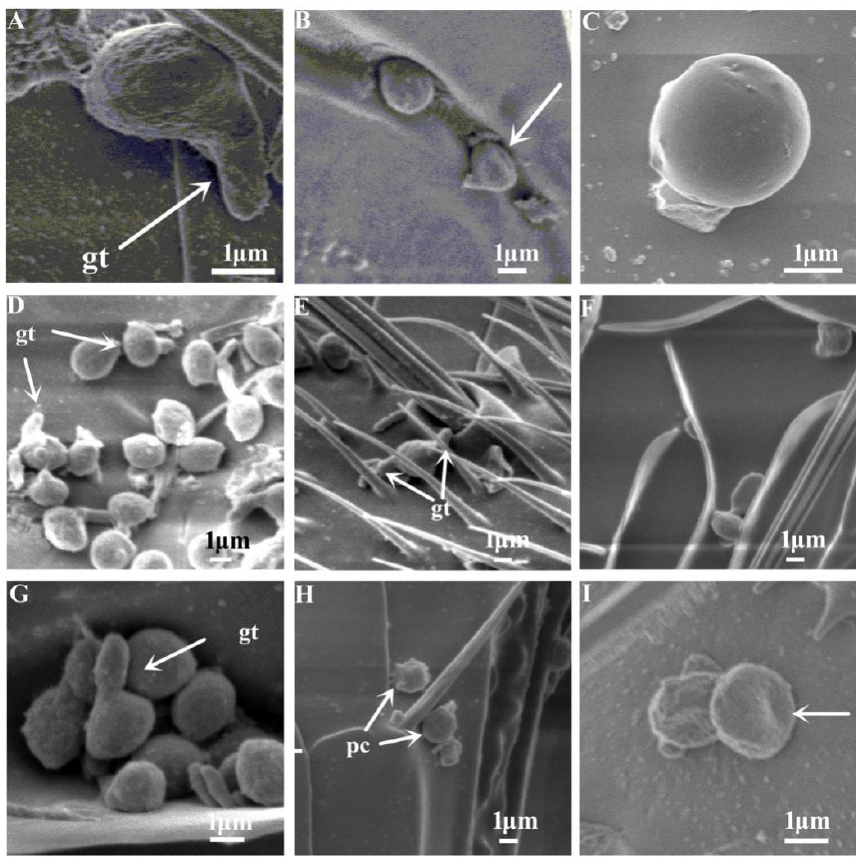
Figure 4. Representative SEM photographs of B. bassiana attachment, germination, and penetration of the F. occidentalis cuticle. ( A ) Fungal germ tube (gt) formation 4 h post-inoculation (p.i.), ( B ) fungal penetration of the integument, 4 h p.i., ( C ) fungal penetration of the cuticle, 4 h p.i., ( D ) conidial germination 8 h p.i., ( E ) bipolar conidial germination, 8 h p.i., ( F ) fungal cuticle penetration/penetrating conidia (pc), 8 h p.i., ( G ) conidial germination, 8 h p.i., ( H ) cuticle penetration, 8 h p.i., and ( I ) shriveled penetrating conidia. Table 2. Quantification of discrete morphological infection stages of B. bassiana on the cuticle of F. occidentalis. Rate